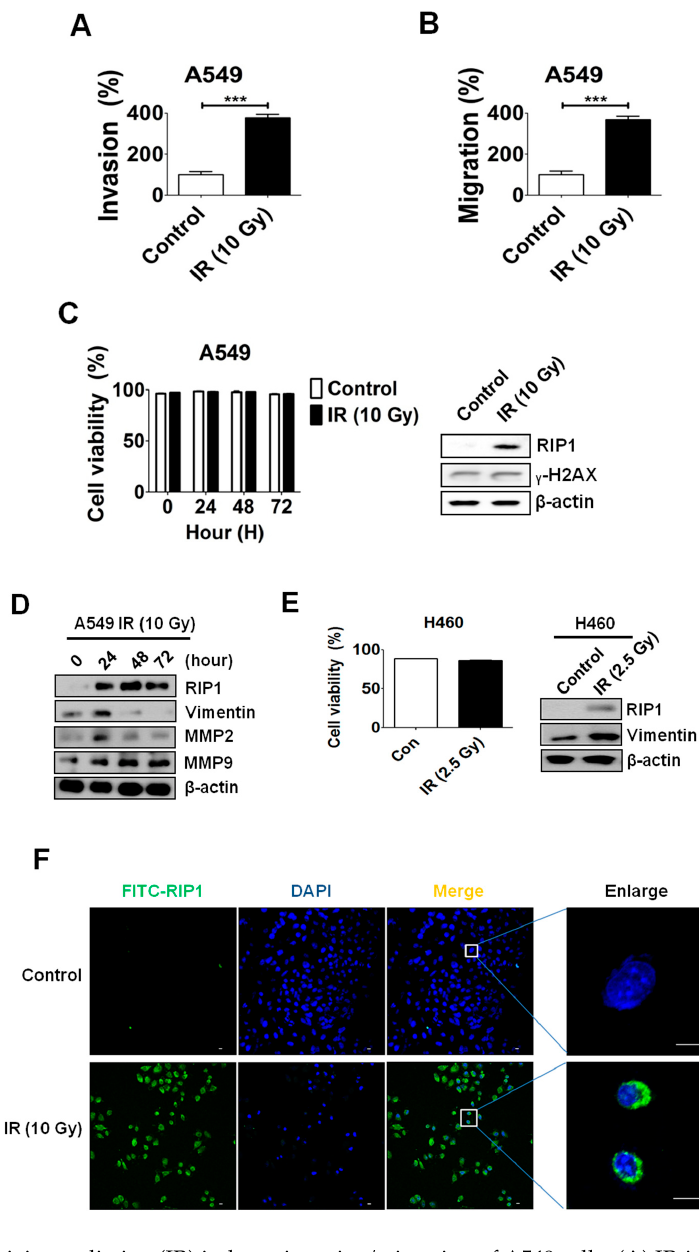
Figure 1. γ -ionizing radiation (IR) induces invasion / migration of A549 cells. ( A ) IR-induced invasion of A549 cells. A549 cells were seeded onto the upper chamber of a transwell system and cells on the membrane were counted after 24 h. (***; p < 0.001) ( B ) IR-induced migration of A549 cells. Experiments were performed as described in Materials and Methods. Representative data from triplicate experiments are shown on the right panel. ( C ) Cells were subjected to IR (10 Gy), and then apoptotic death and γ -H2AX expression was determined using the propidium iodide (PI) uptake assay and immunoblot analysis, respectively. Representative data from triplicate experiments are shown. ( D ) Lysates from A549 cells treated with IR (10 Gy) for the indicated periods were subjected to Western blot analysis for RIP1, vimentin, MMP-2, MMP-9 and β -actin (loading control). Data are representative of triplicate experiments. ( E ) cell viability and immunoblot analysis of NCI-H460 cells. ( F ) Immunofluorescence staining of RIP1-positive A549 cells after exposure to IR. Endogenous RIP1 expression in IR-treated or non-treated A549 cells was determined via immunofluorescence staining. A549 cells were stained with DAPI to visualize nuclei (blue) and immunolabeled with an anti-RIP1 antibody, which was detected via addition of FITC-conjugated IgG (green). Scale bar: 10 µ